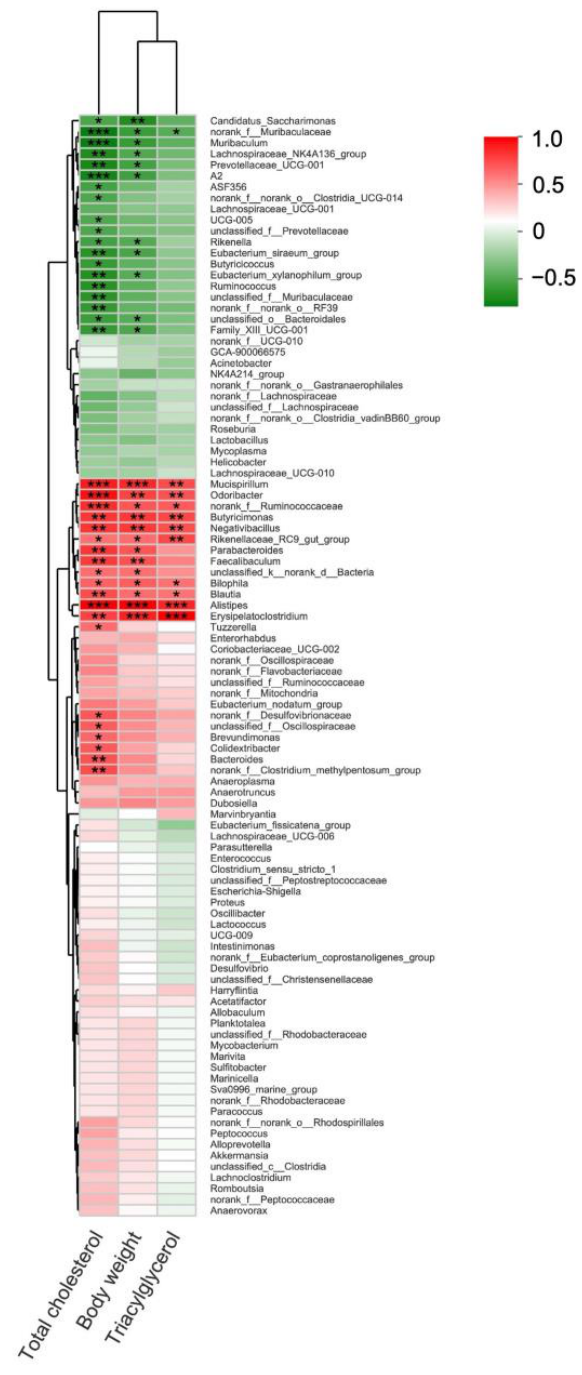
Figure 6. Pearson’s correlation analysis of different gut bacteria at the genus level with triacylglycerol, body weight and cholesterol. Correlations with R > 0.4 or R < − 0.4 were identified by asterisks. * p < 0.05, ** p < 0.01, *** p < 0.001.